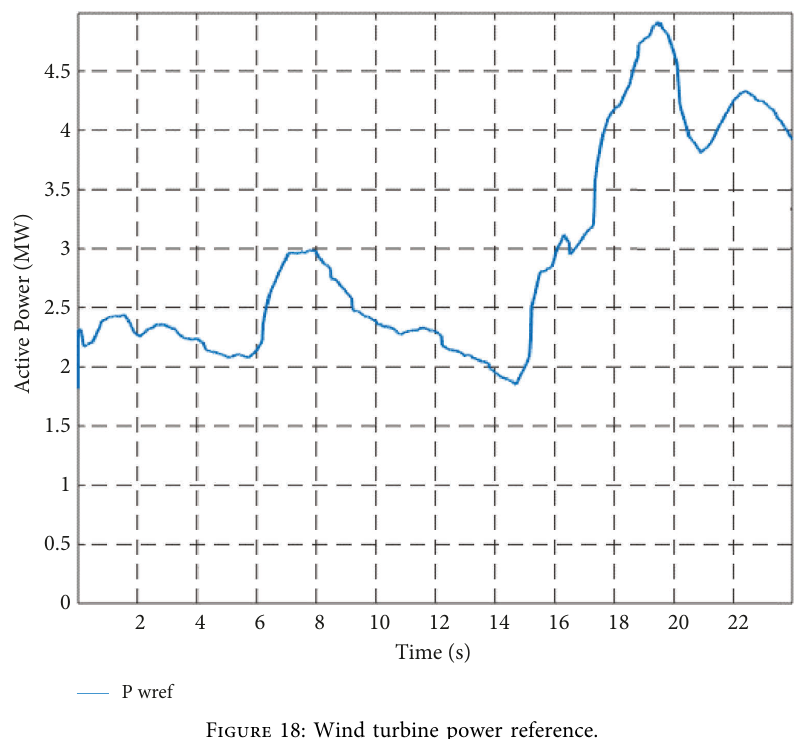
Figure 18: Wind turbine power reference.